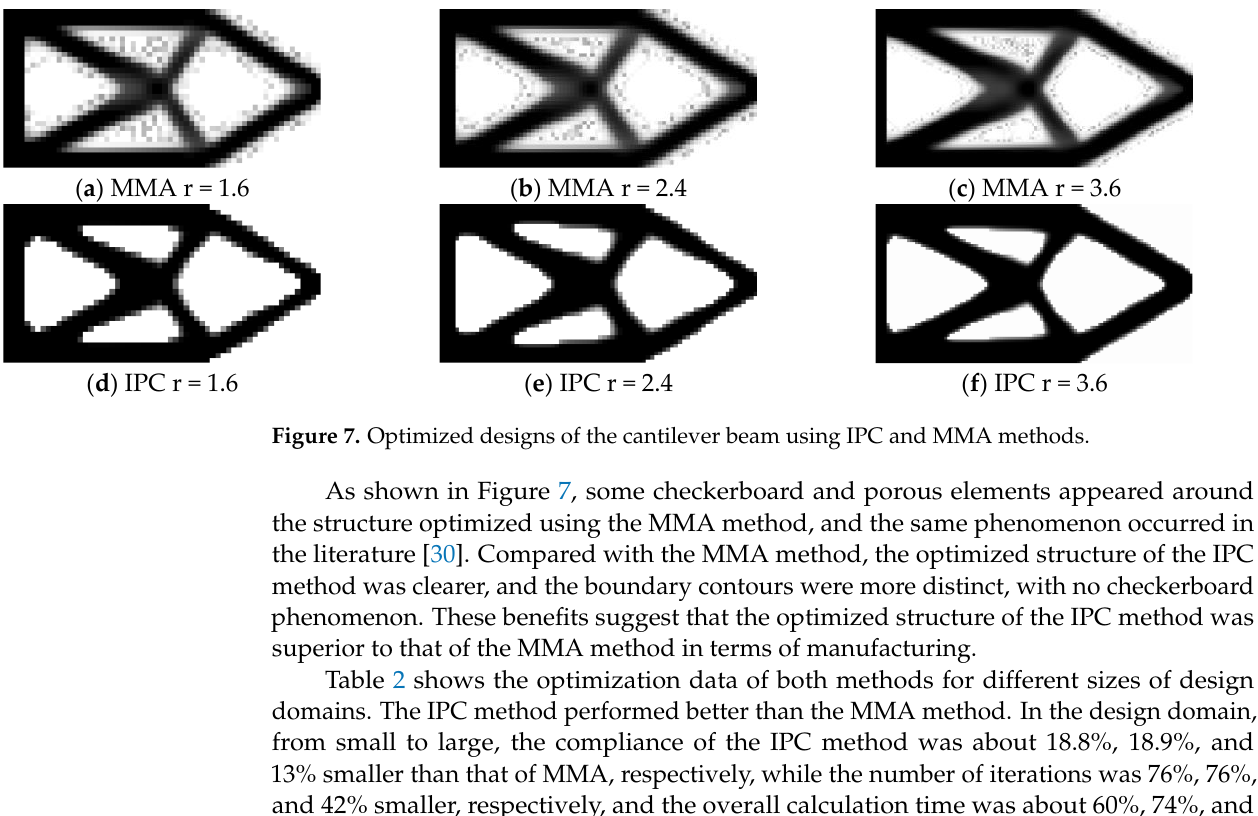
Figure 6. Design domain of the cantilever beam.